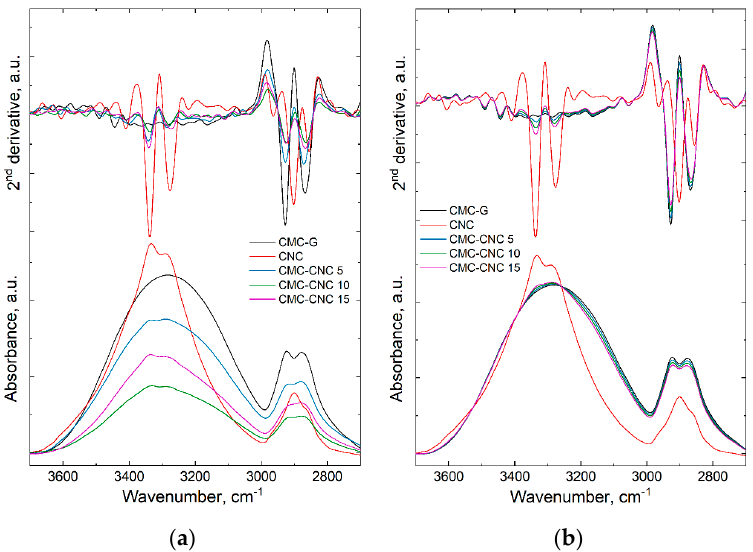
Figure 2. Experimental ( a ) and theoretic ( b ) infrared spectra and their second derivatives in the 3700–2700 cm − 1 region of the components and nanocomposites.